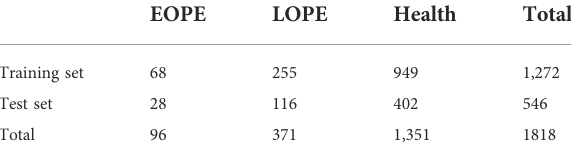
TABLE 6 Parameters eventually incorporated into the model. TABLE 7 The dataset of the